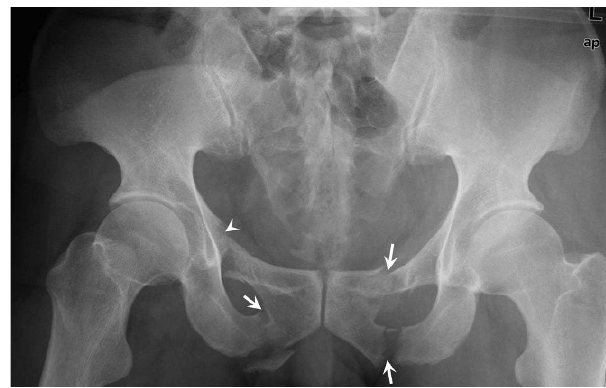
Figure 1 - The digital radiograph of fractured pelvis of a 45-year- old man depicts fractures in left inferior and superior pubic ramus, in right inferior pubic ramus (white arrows), and in superior pubic ramus involving acetabulum (white arrowhead); and the pelvic ring fracture is classified as Type C.